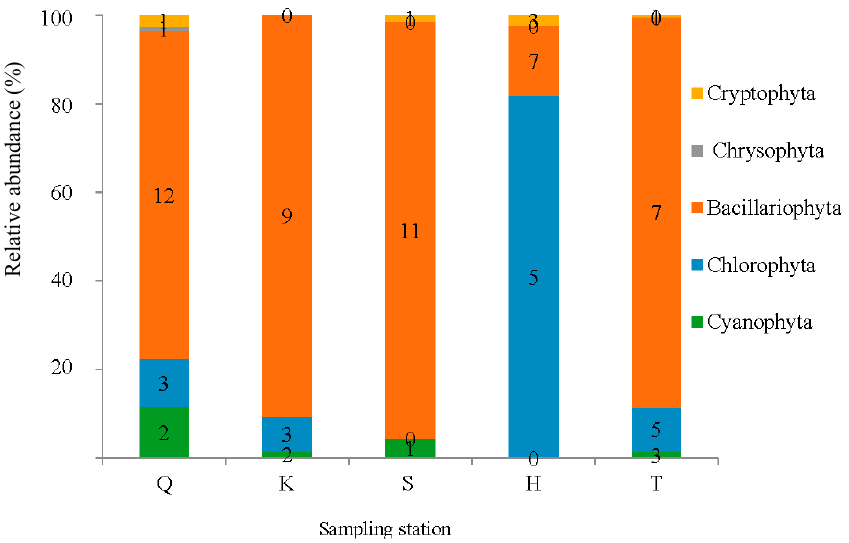
Figure 2. Relative abundance (%) of biomass and taxa number of phytoplankton assemblages by traditional optical microscopy method (TOM). Station codes represented the first letter of their names: Q: Qushou, K: Kuxin, S: Songgan, H: Heijizuo, T: Taizishang.